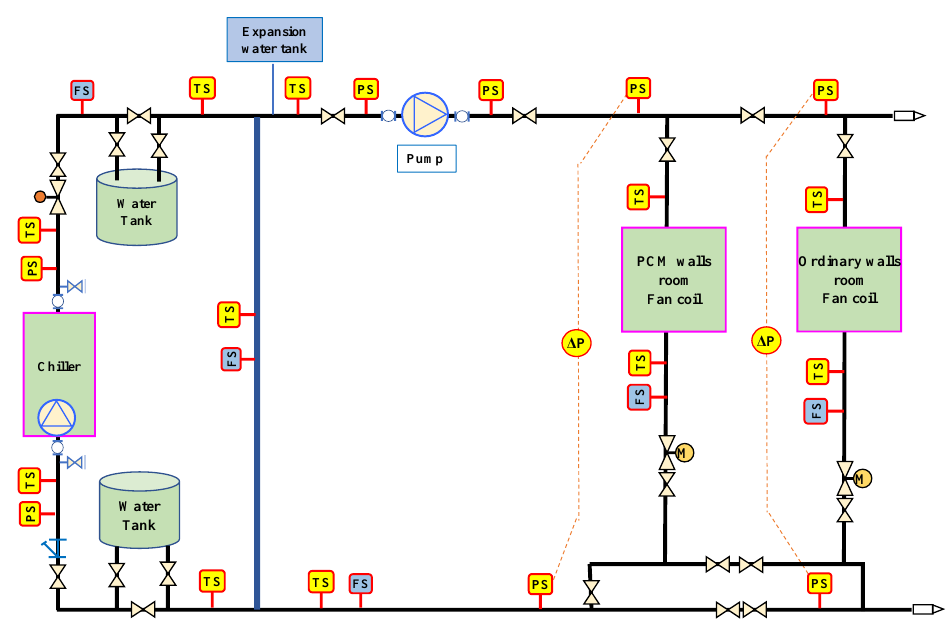
Figure 3. Pipeline monitoring points.